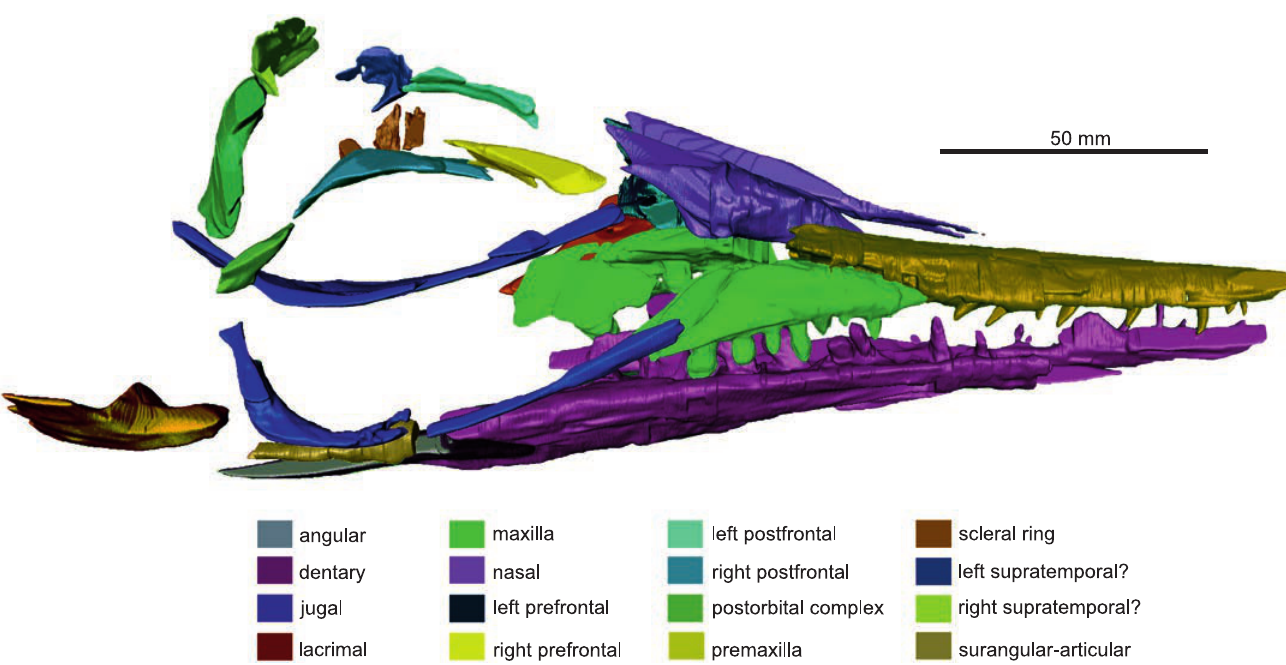
Fig. 2. The segmented model of right lateral side of the skull of mixosaurid ichthyosaur Phalarodon fraasi (Merriam, 1910) PMO 235.393, from the Botneheia Formation, Middle Triassic of the Isfjorden area in Spitsbergen,